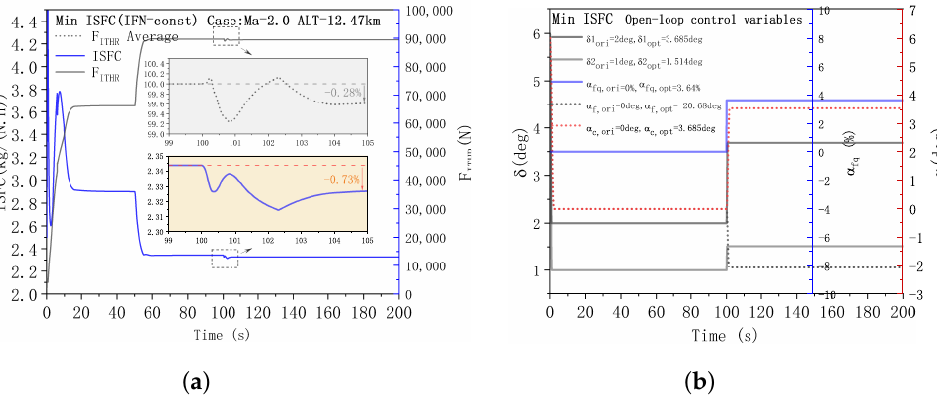
Figure 13. ( a ) Simulation analysis of incorporating PSC Min ISFC module and ADRC controller. ( b ) Dynamic analysis of the open-loop controlled variables α fq , δ 1 , δ 2 , A 8 , α f , α c under Min ISFC